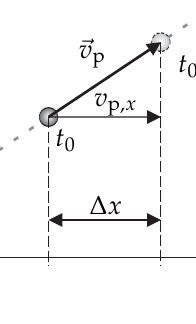
Figure 3. Measurement arrangement of time-of-flight principles illustrated for the position measurement of a scattering particle (measurement of one velocity component, acceleration neglected).